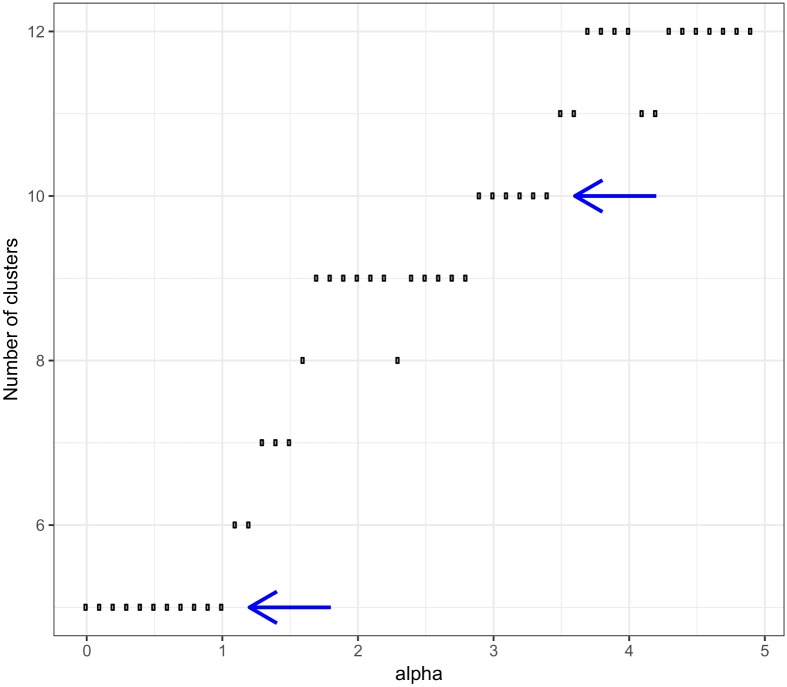
Number of clusters in case of different α.